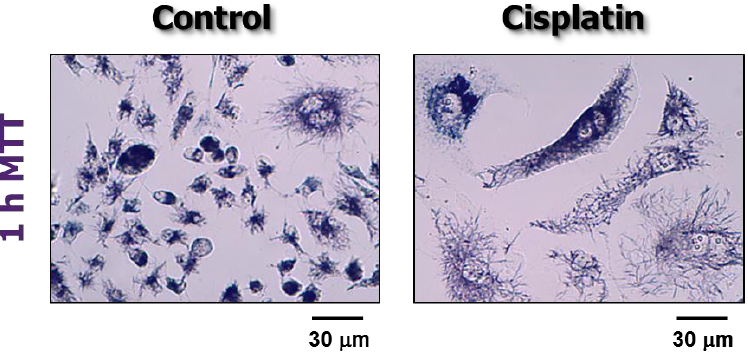
Figure 2. Bright-field microscopy images showing viability of MDA-MB-231 cells before (control) and after incubation with cisplatin (10 µM) for 72 h. Viability was measured by the ability of the cells to convert the 3-(4,5-dimethylthiazol-2-yl)-2,5-diphenyl-tetrazolium bromide (MTT) reagent to its formazan metabolite (dark granules and crystals). Images were acquired after incubation of cells with MTT for ≈ 1 h. Data reproduced from Mirzayans et al. [30].